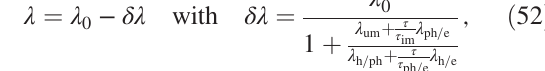
FIG. 6. Comparison with the experiment of Liz´ee et al. [19]. (a) Schematic of the experimental setup. Thanks to an atomic force microscope (AFM), a liquid droplet is deposited onto the surface of a multilayer graphene sample connected to two metallic electrodes. Actuation of a piezoelectric scanner results in motion of the drop on the carbon surface at a velocity v . drop (b) Quantitative comparison between the experimental data for the electrofluidic conductivity σ from three different devices ef and theoretical predictions, parametrized by the wrinkling num- ber W that account for the wrinkle density on the sample